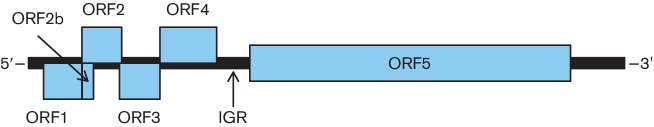
Genome map of SINV-2. The genome is represented by a black line. ORFs are indicated in pale blue with vertical offsets indicating the reading frame (−1, 0, +1) relative to ORF5. IGR, intergenic region.